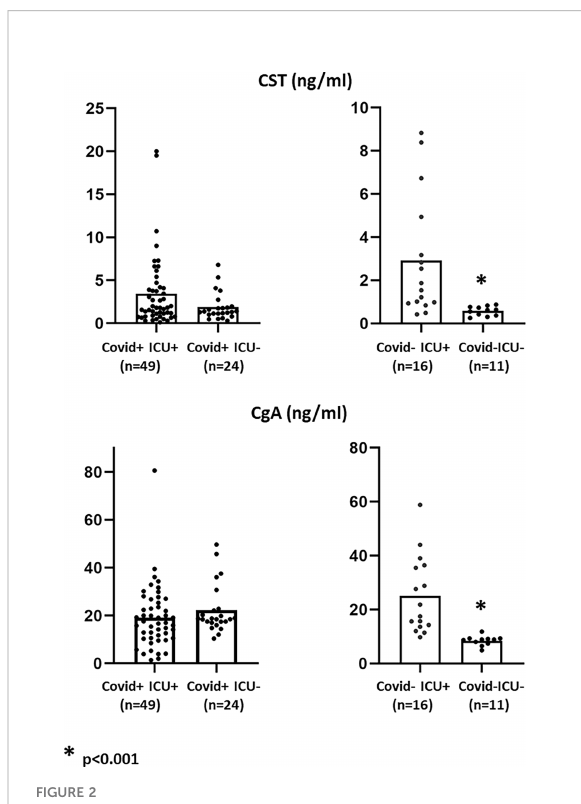
FIGURE 2 Admission concentrations of CST (top) and CgA (bottom) in the different study groups. On admission, whether COVID+ or not, patients had signi fi cantly ( p < 0.001) higher plasma CST concentrations than healthy controls (COVID-, ICU-) without difference between COVID+ICU+ and COVID+ICU-. Admission CgA concentrations were decreased only in healthy